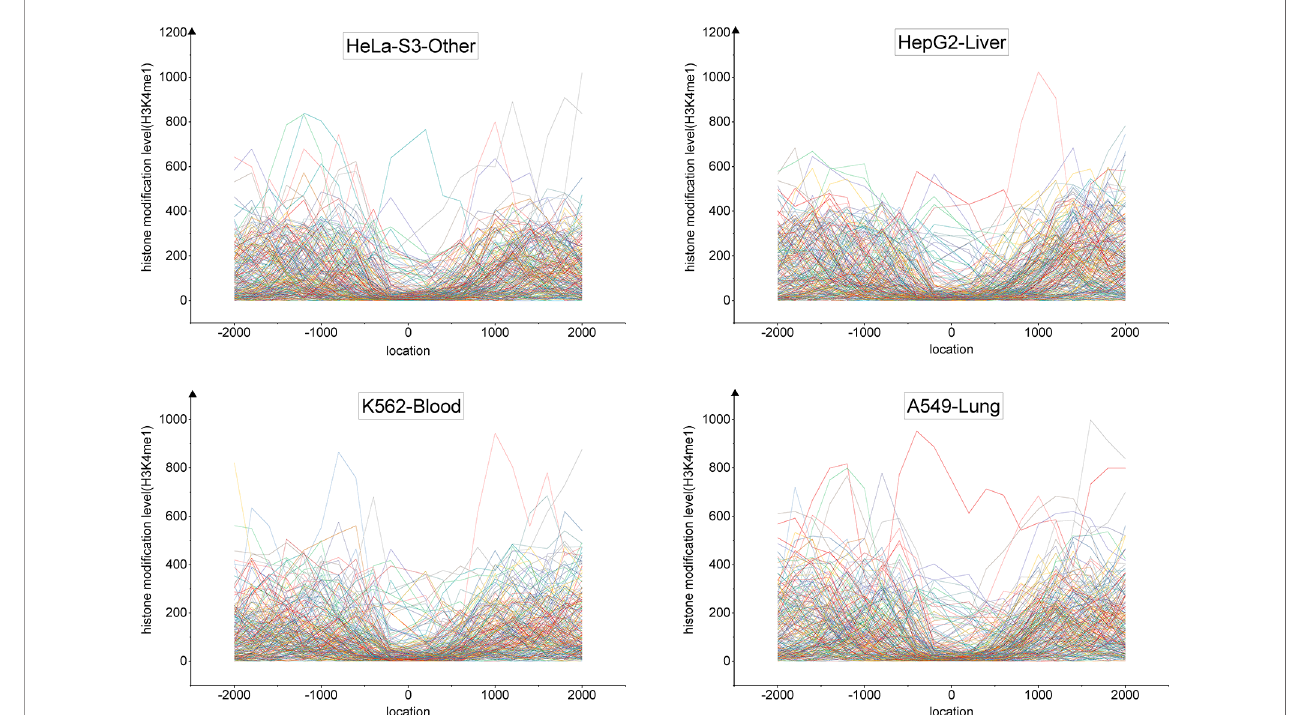
FIGURE 2 | The pro fi les of epigenetic mark H3K4me3 in a typical bi-Cluster exhibit a similar pattern in four cancer types, including Hela-S3, HepG2, K562 and